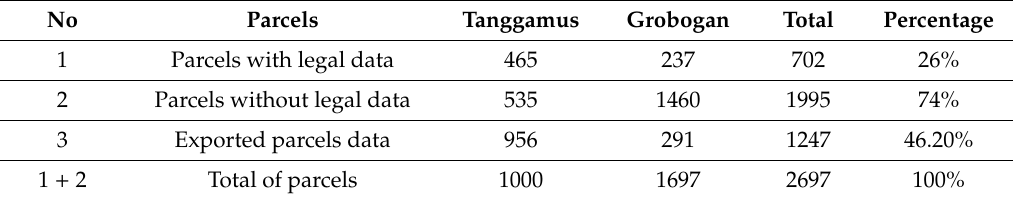
Table 2. PaLaR land parcels of Tanggamus and Grobogan pilots